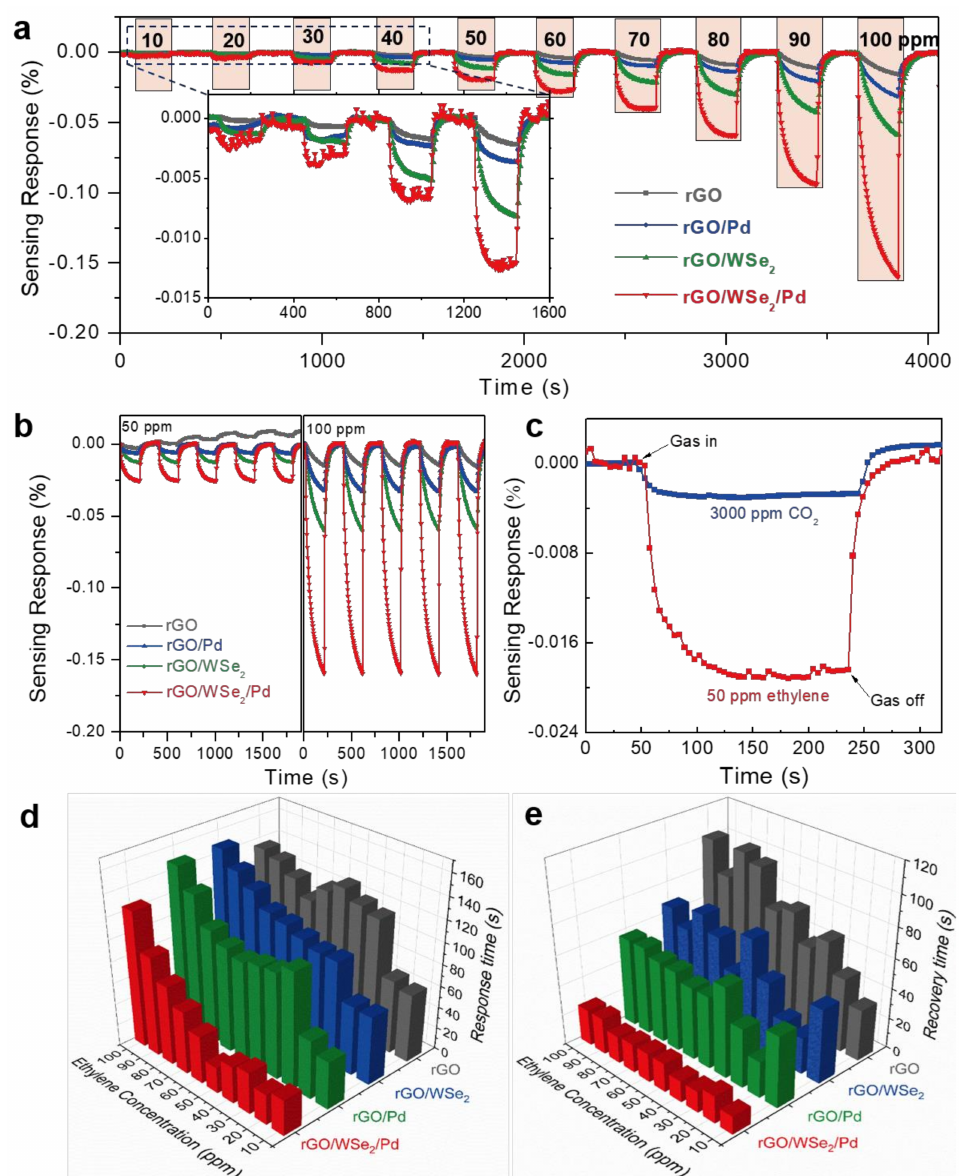
Figure 4. ( a ) Real-time sensing response of rGO-based self-assembled sensitive film to 10–100 ppm ethylene at room temperature, ( b ) repeatability, and ( c ) selectivity properties of self-assembled rGO/WSe 2 /Pd sensitive film when exposed to ethylene. ( d ) Response time and ( e ) recovery time of the ethylene sensor based on rGO/WSe 2 /Pd sensitive